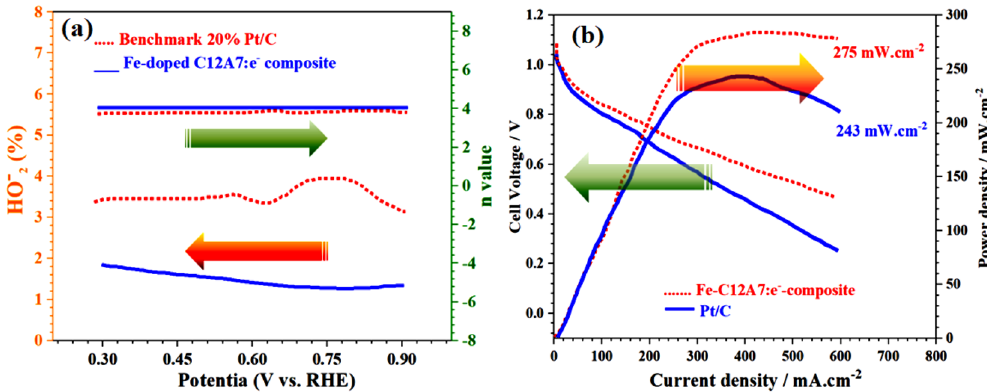
Figure 11. ( a ) HO 2 − % yield for oxygen reduction reaction, (b ) Cell voltage and power density versus current of Fe-doped C12A7:e − composite (x = 1) catalyst as a cathode for AAEMFC.